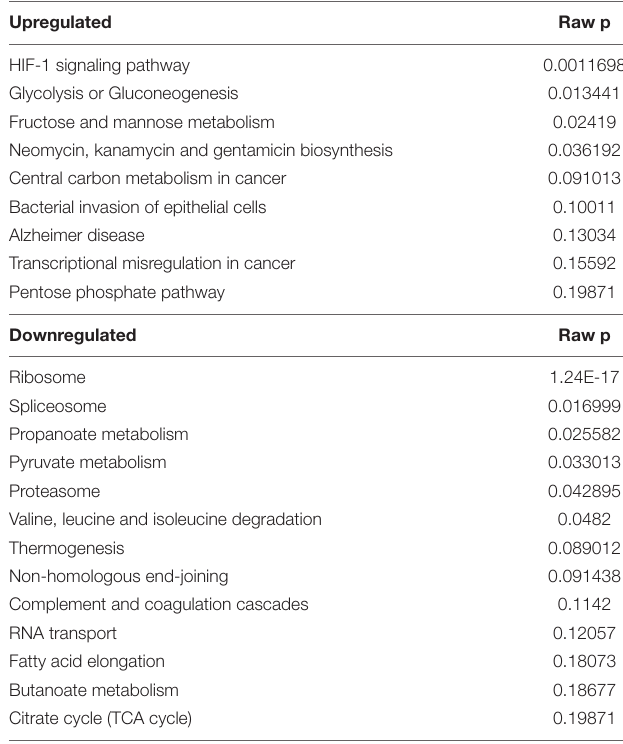
TABLE 3 | Differential expression of pathways in PBMC from PM